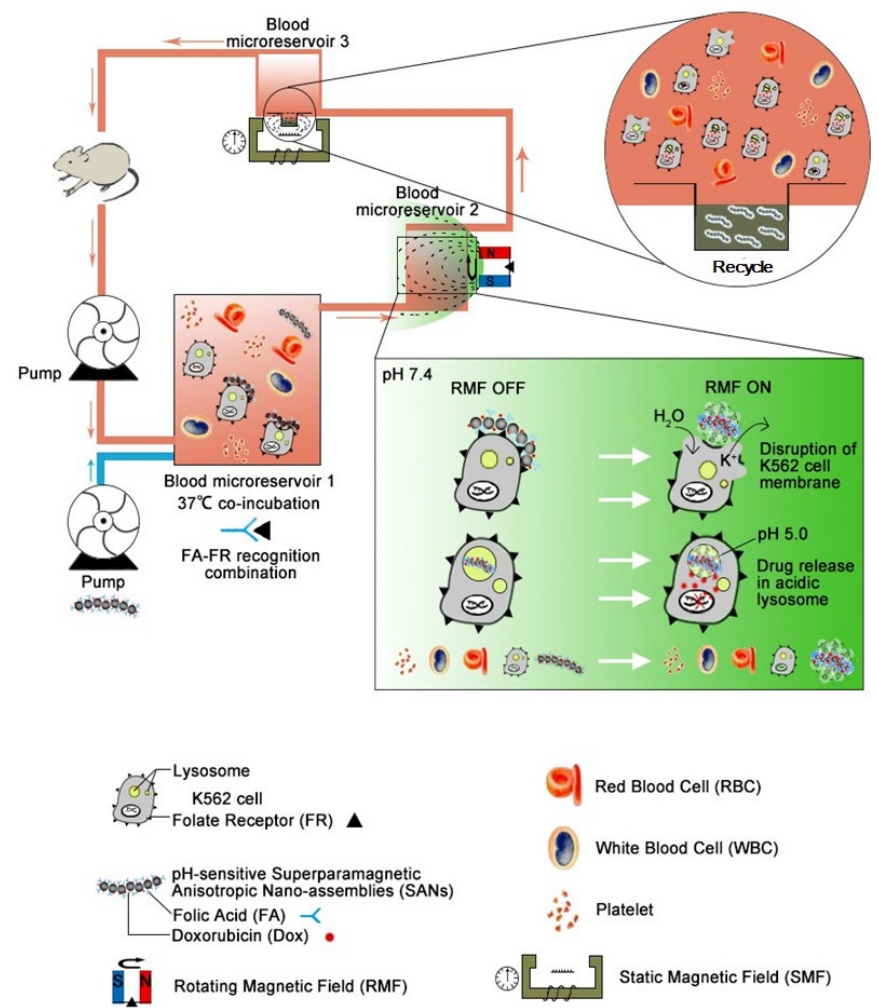
Figure 1. Schematic diagram of the nanochains used to eliminate the leukemic cells during the extracorporeal blood circulation.